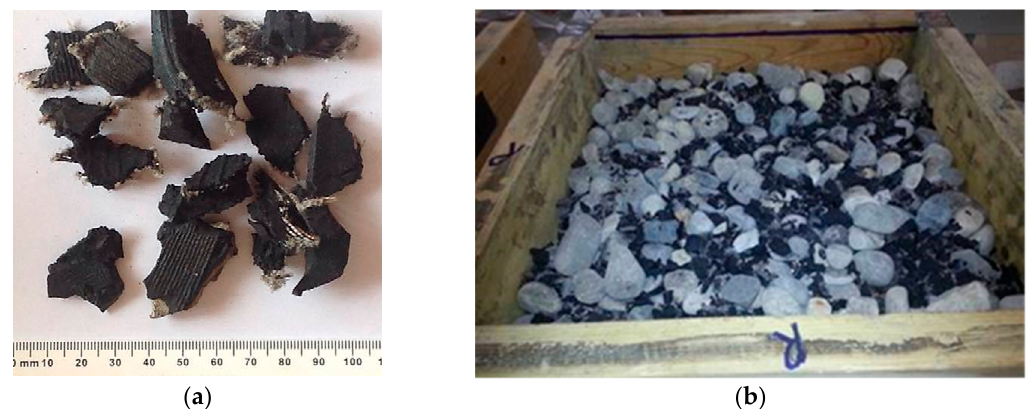
Figure 3. Overview of ( a ) tire rubber particles, and ( b ) preplaced RCA with scrap tire rubber granules and steel